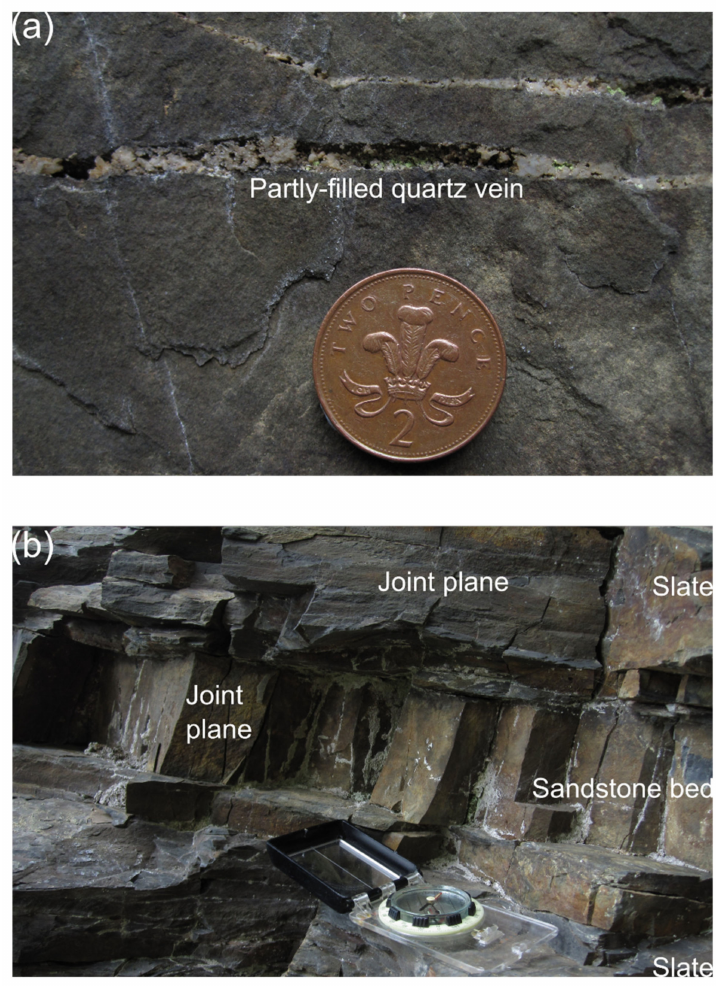
Figure 3. Photographs of different types of “fractures” in the Harz Mountains. ( a ) Partly filled quartz vein in a sandstone, which resulted from and gives information about palaeo fluid flow. The vein was either never completely cemented or has been subjected to weathering. The quartz will hinder present-day fluid flow through the vein. ( b ) Joints in sandstones and slates. Veins are (by definition) not mineralised, so are potential pathways for present-day fluid flow in the